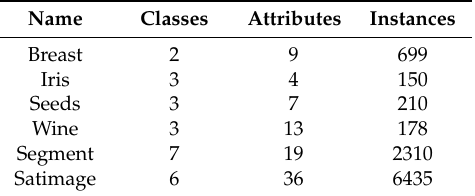
Table 1. The specification the selected data